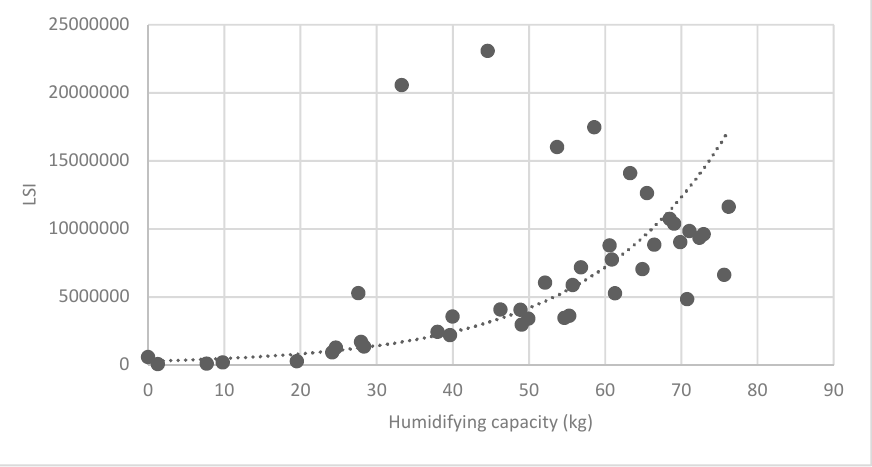
Figure 28. Association between brush LSI and humidifying capacity.